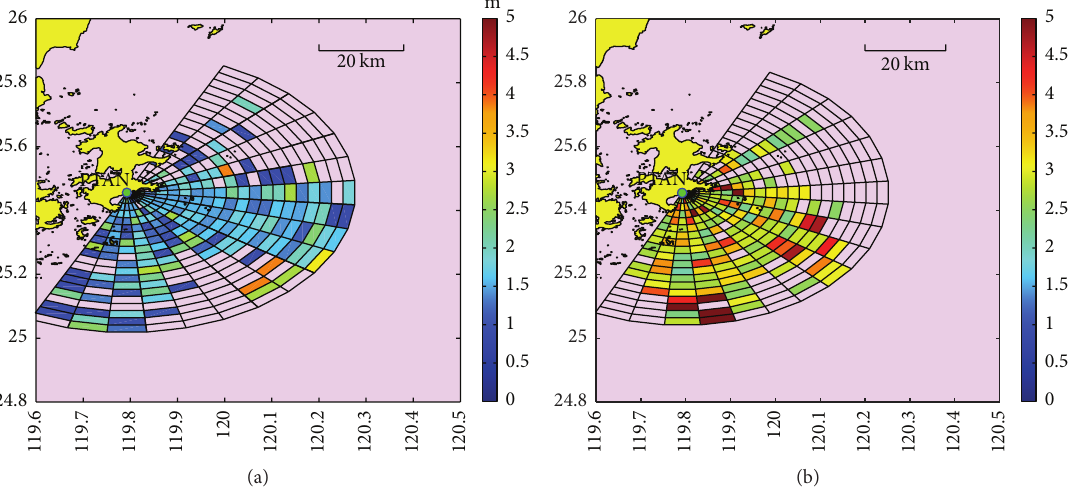
Figure 5: The initial wave maps, the sea area is divided into a series of two-dimensional space grids with the range resolution 2.5 km and the azimuth 10 degrees. (a) 21:00 to 23:00 Sep 27, 2014; (b) 17:30 to 19:30 Oct 9,